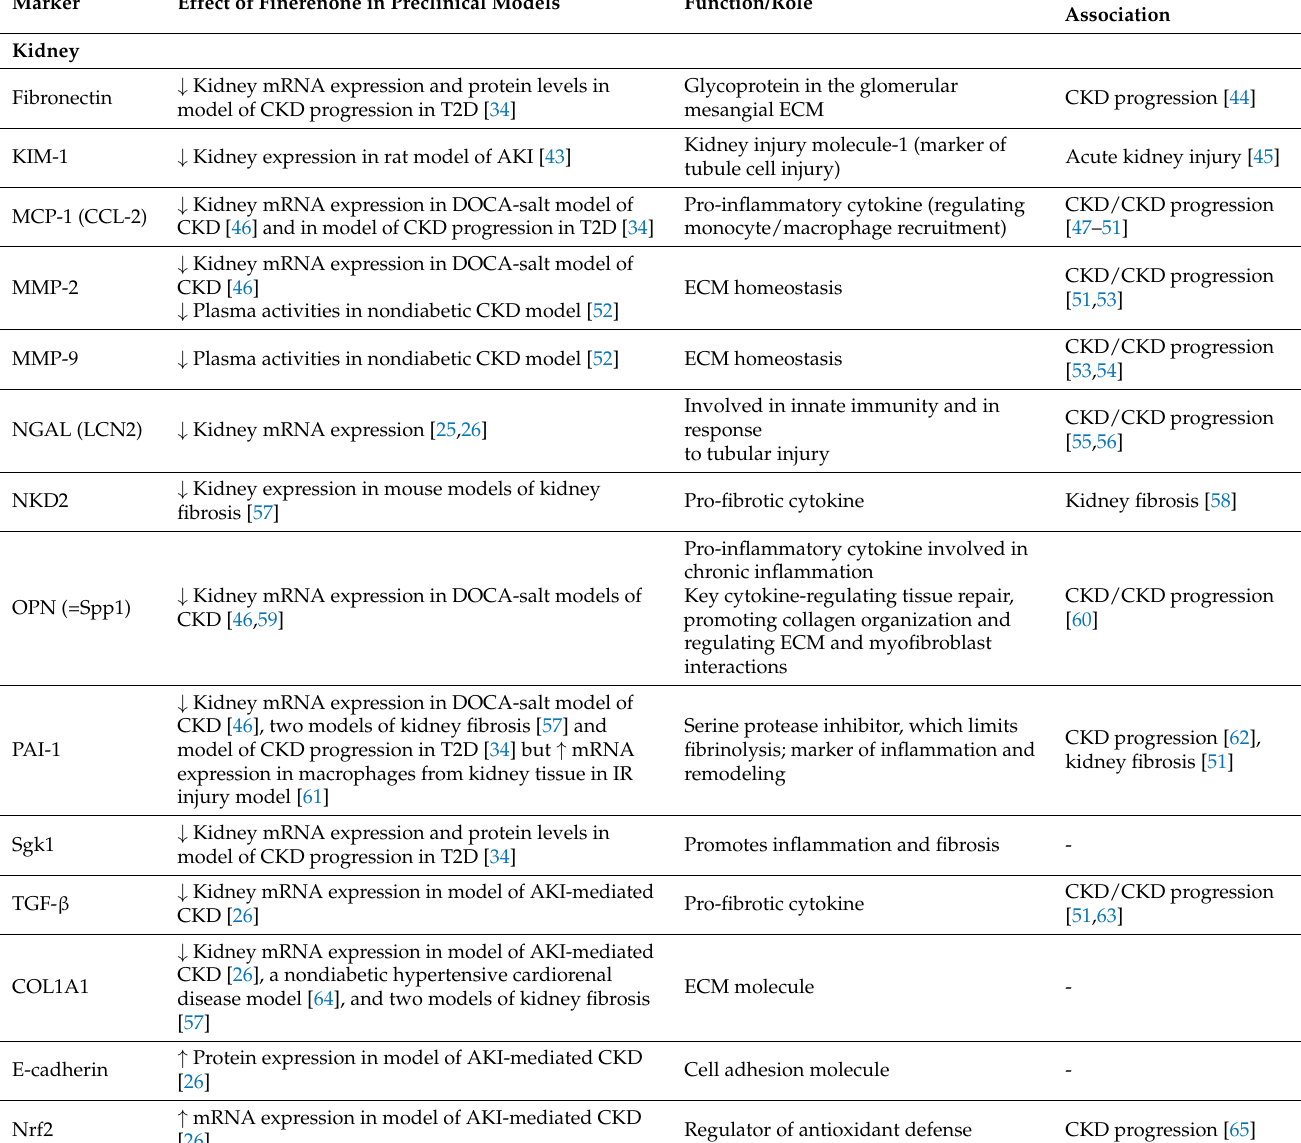
Table 1. Renal biomarkers modulated by finerenone in preclinical studies and their clinical